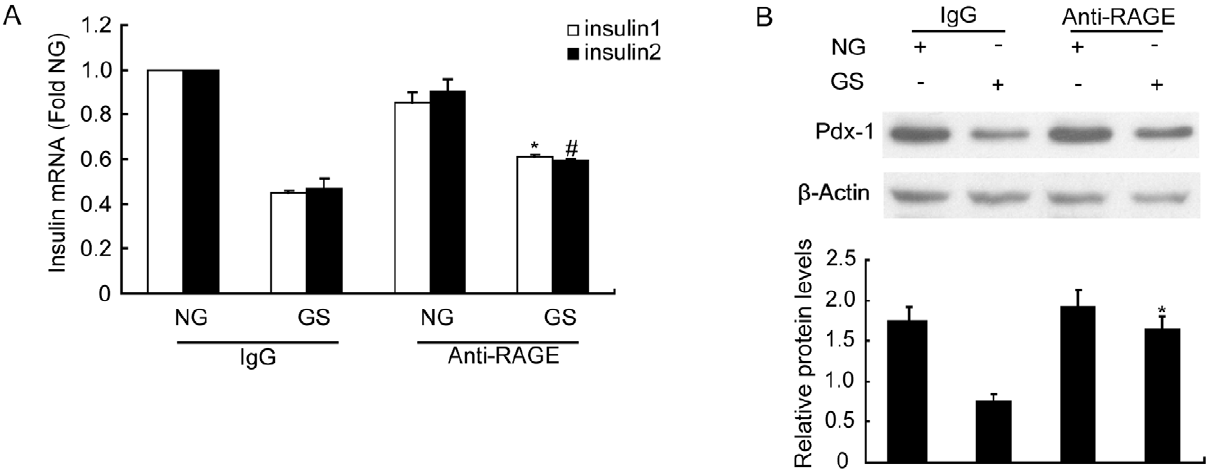
Figure 5. RAGE antibody reversed glycated serum (GS)-induced impairment of Pdx-1 protein expression and insulin mRNA expression. (A) INS-1 cells were pretreated with RAGE antibody for 1 h and then treated with nonglycated (NG) or 10% GS for a further 24 h. Insulin mRNA was measured by real-time PCR assay. (B) With the same treatment, Pdx-1 protein level was determined by western blot assay. Representative immunoblots and a graph showing the protein levels of Pdx-1 relative to b -actin are presented. Data are represented of three separate experiments. *p , 0.05 vs. the GS IgG Insulin1 group; # p , 0.05 vs. the GS IgG Insulin2 group; *p , 0.05 vs. the GS IgG group.